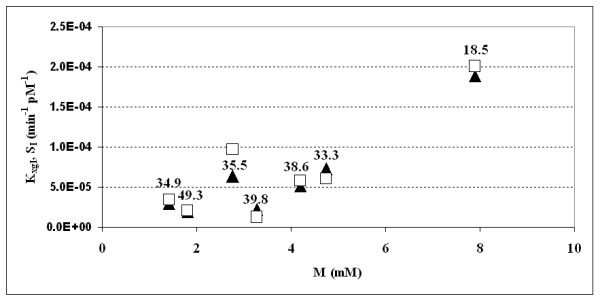
Scatter plot of the two Insulin Sensitivity Indices (KxgI and SI) versus the M clamp-derived index of insulin sensitivity in seven subjects undergoing both IVGTT and Clamp. Each couple of points has been labelled with the subject's BMI. Solid triangles = Single Delay Model KxgI, blank squares = Minimal Model SI.